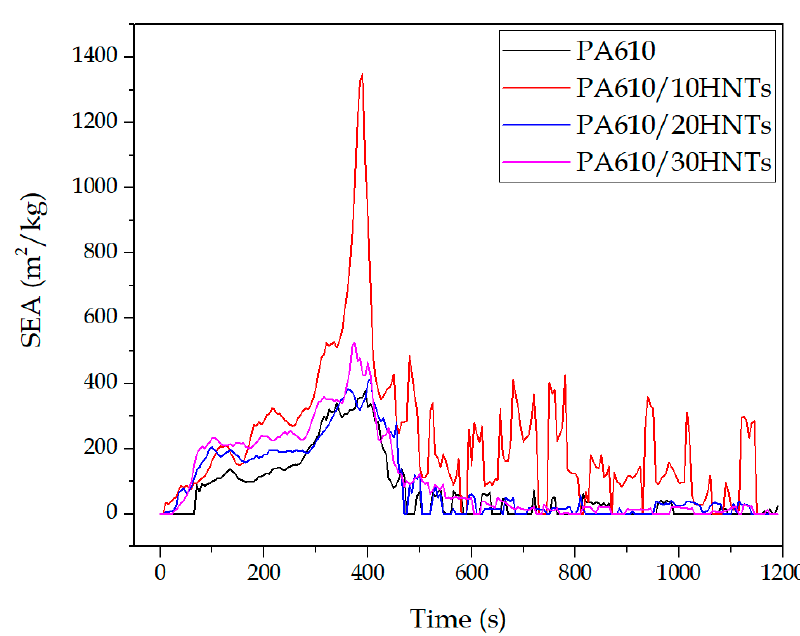
Figure 6. Specific extinction area for PA610 samples loaded with HNTs.